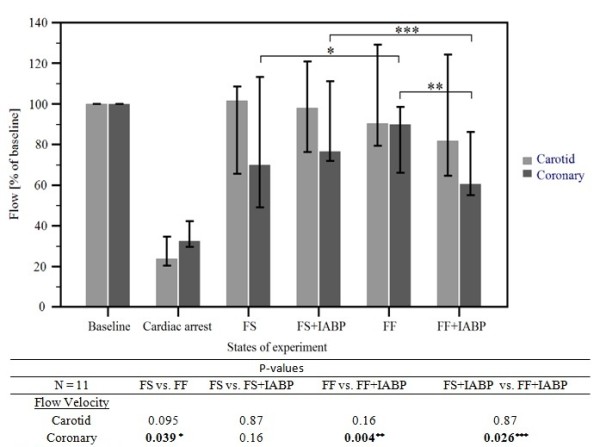
Carotid and coronary blood flow velocities relative to baseline. Values are expressed as median percentages of baseline with 25- and 75-percentiles represented by the vertical bars (for actual values see Table 1) along with P-values for respective comparisons at the bottom. Statistically significant differences in bold. Cardiac arrest values are significantly different to all other values, comparisons not shown.